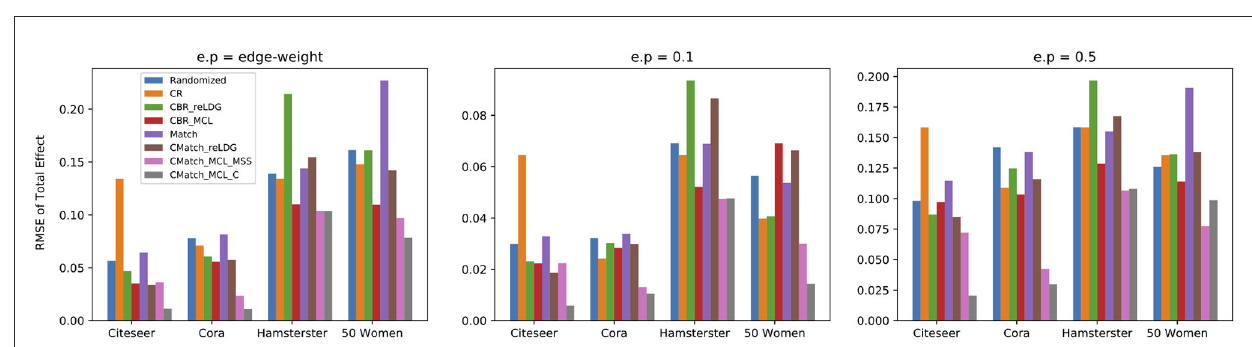
FIGURE11 RMSE of total effect in the presence of contagion considering different unallowable spillover probabilities in all datasets; CMatch MCL lowest error in all